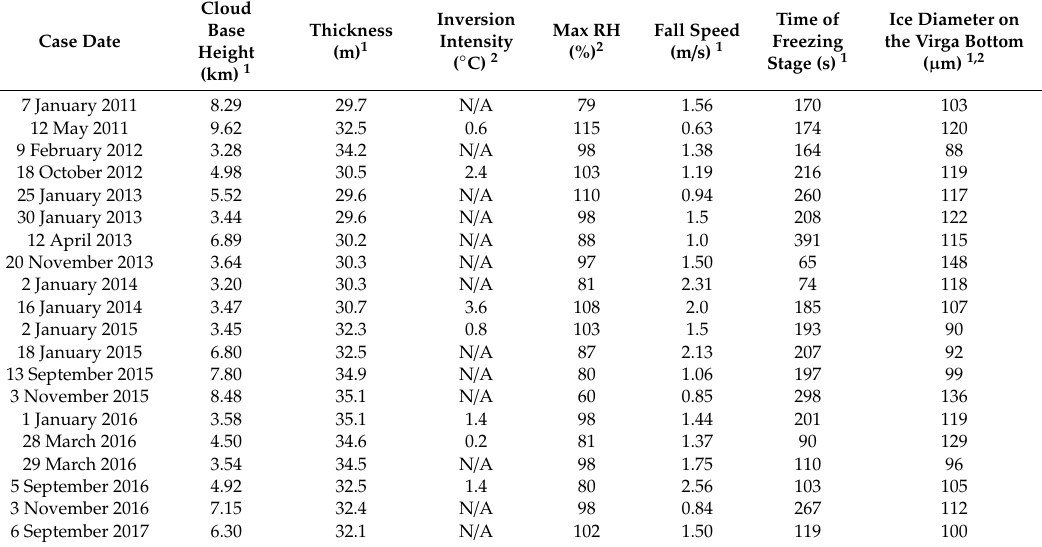
Table 1. Case data obtained by our lidar and radiosonde are listed below. Thickness is the height di ff erence between liquid layer top and cloud base. Cloud base height and thickness represent the mean values of each case. The inversion layer all occurs at the height of the liquid cloud layer and Max RH refers to the maximum RH over ice within the ice virga layer. The last three terms are estimated by the method of the previous two